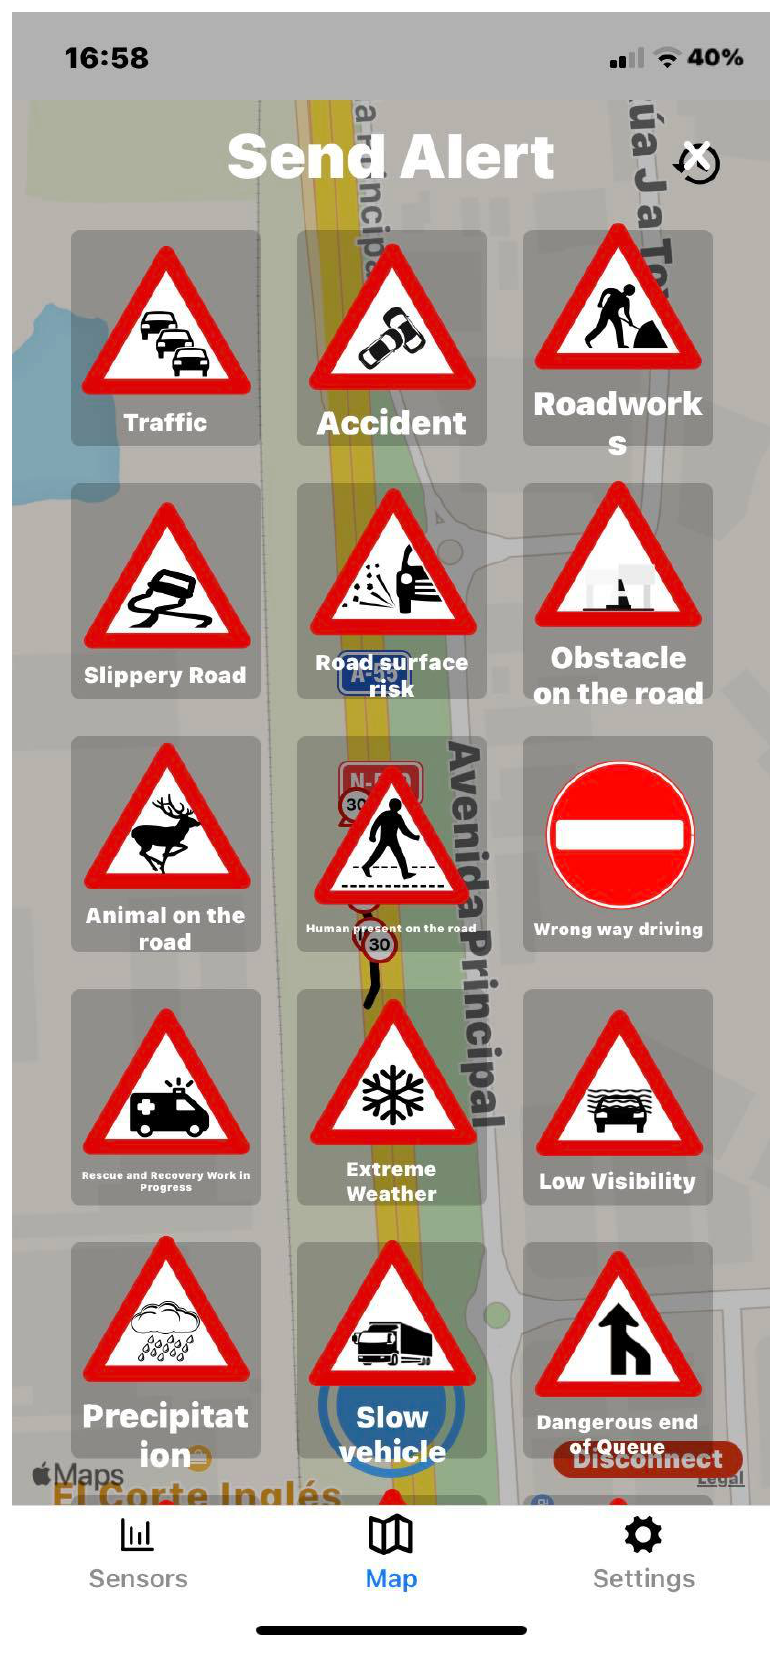
Figure 11. DENM message generation in the mobile